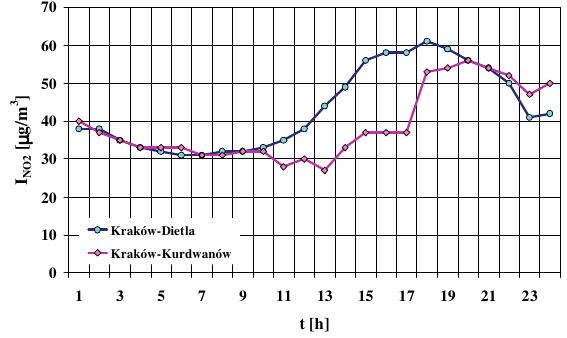
Fig. 7. The immission of nitrogen dioxide on 6 January 2016